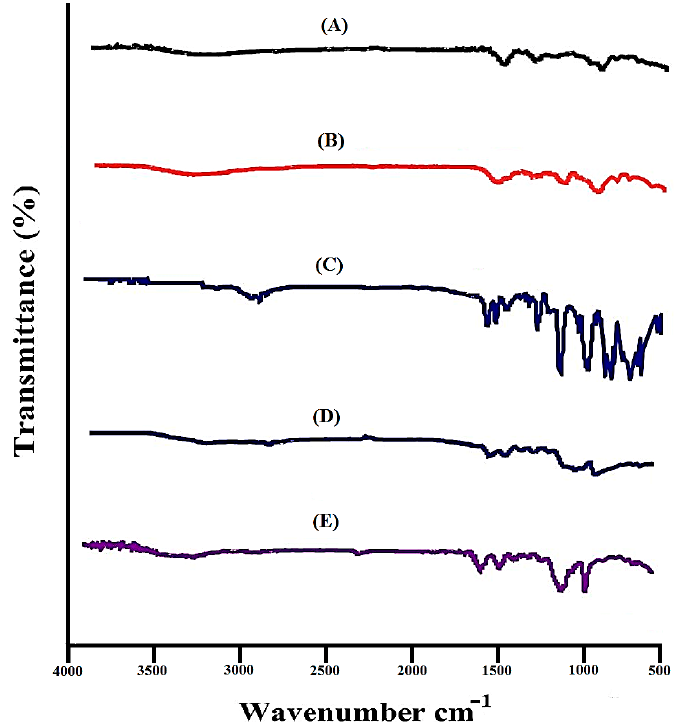
Figure 2. FTIR spectra of ( A ) DS, ( B ) SA, ( C ) AMPS, ( D ) unloaded SA-co-poly(AMPS) hydrogeI ( E ) loaded SA-co-poly(AMPS) hydrogel.